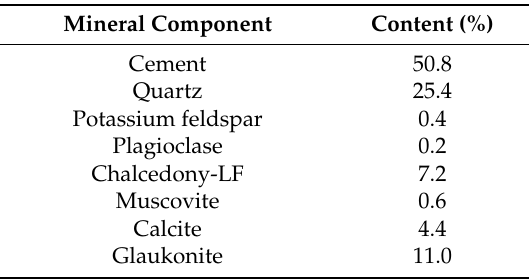
Table 3. Mineral composition of quartz-glaukonite sandstone.